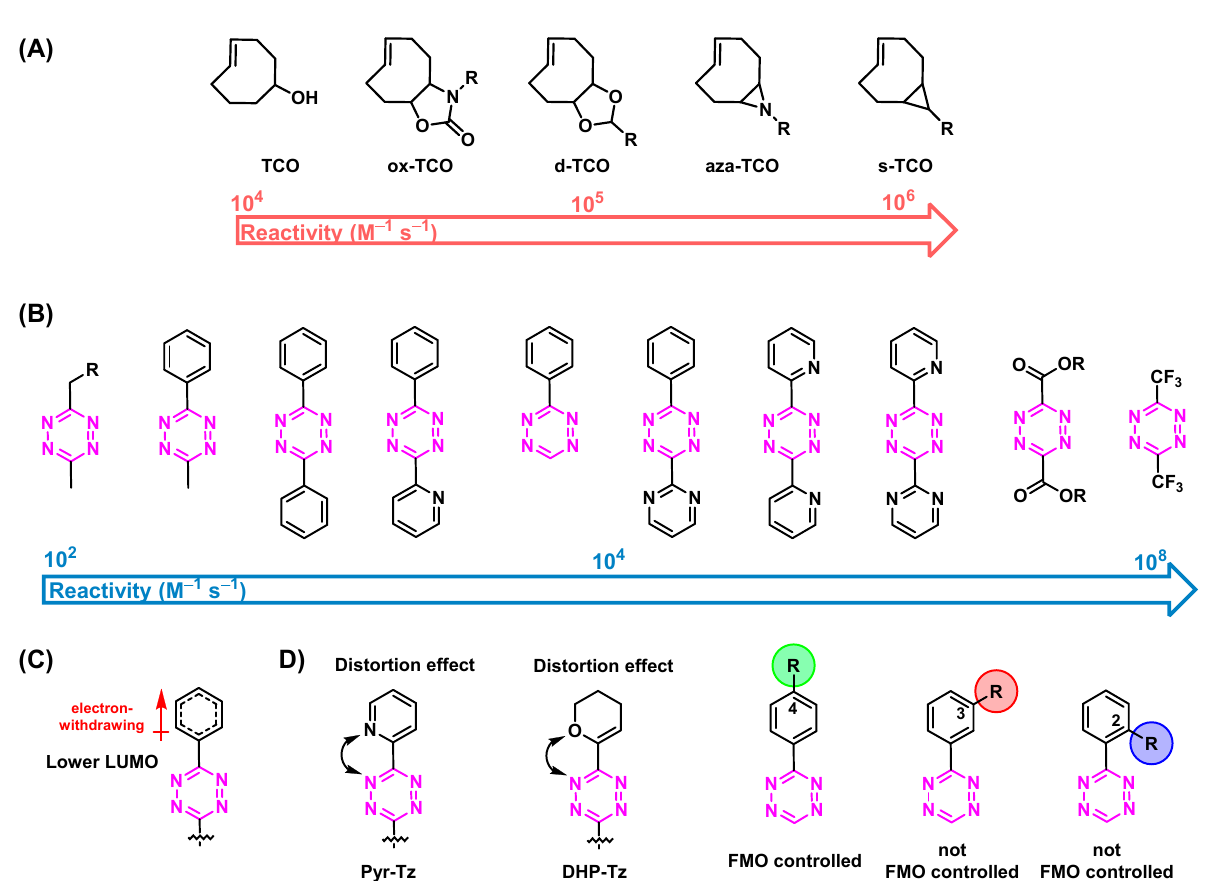
Figure 3. ( A ) Structures and reactivity order of TCOs. Increased strain leads to higher reactivity. Reactivity calculated with bispyridyl Tz, as reported in ref. [39]. ( B ) Structures and reactivity order of Tz scaffolds. The activity is dependent on electronic and steric effects. ( C ) Tz can be activated by conjugation of an electron-withdrawing group (EWG) to the aromatic Tz system. The LUMO Diene will be shifted to a lower energy level. ( D ) The substitution pattern also influences the Tz’s reactivity. Distortion, steric effects, and solvent interactions are responsible for the observed reactivity trend.